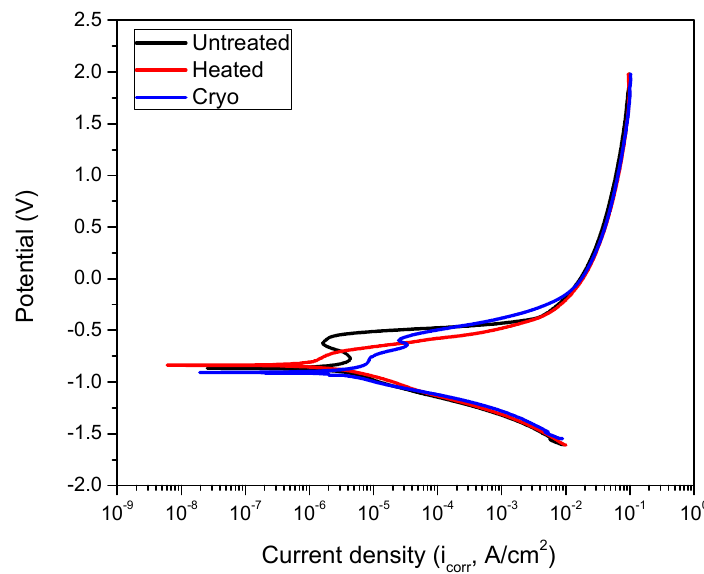
Figure 7. Potentiodynamic curves of investigated surfaces. Table 1. Main corrosion parameters of untreated, heated and cryo specimens. E i = 0: corrosion potential; i corr : corrosion current density; R p : polarization resistance; P: porosity; P e : protective efficiency; CR: corrosion